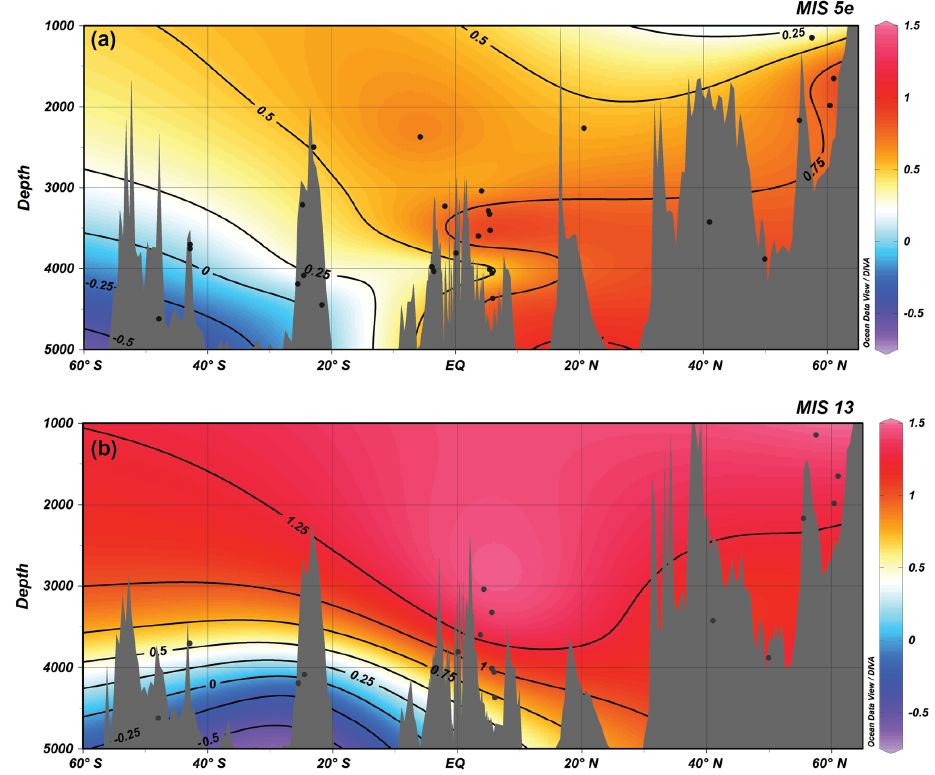
Figure 9. MIS 13 and 5e contour plots of ∂ 13 C. Contour plots of the ∂ 13 C values in the North Atlantic basin for the interglacials MIS 13 and MIS 5e. Red colors represent more positive, enriched values. Blue colors represent lower, depleted values. The plot was created using Ocean Data